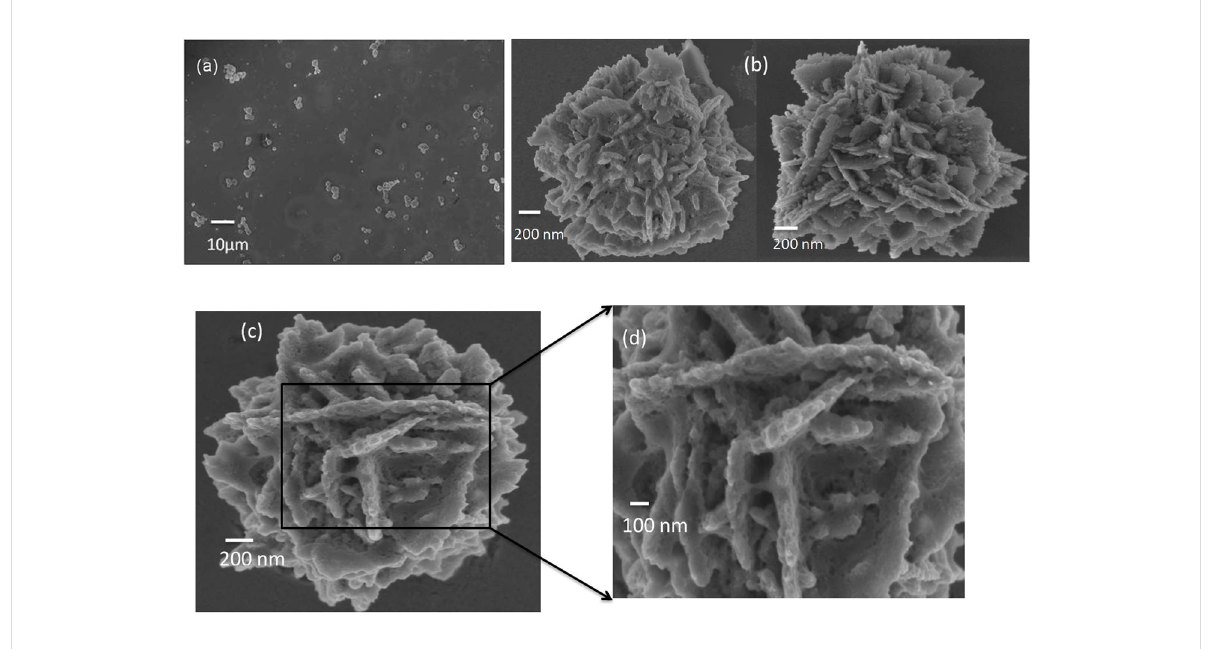
Figure 2: SEM image of sample S2 showing flower-like structures consisting of nanosheets made up of nanoparticles.